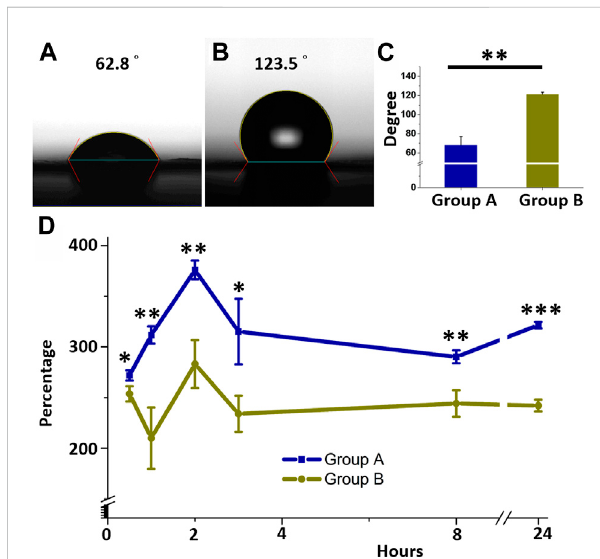
FIGURE 3 Water contact angles and water uptake. Core-shell insulin/PLGA with vildagliptin (A) or without vildagliptin nano fi brous scaffolds (B) . Measured contact angles of two groups (C) . Variance between water absorbent capacities of two nano fi brous groups over time (D) . * p < 0.05, ** p < 0.01, *** p <